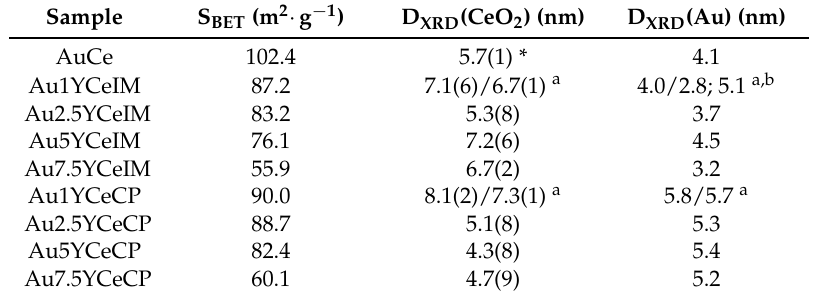
Table 1. BET surface area (S BET ), mean size (D) of ceria and gold crystallites estimated by XRD.